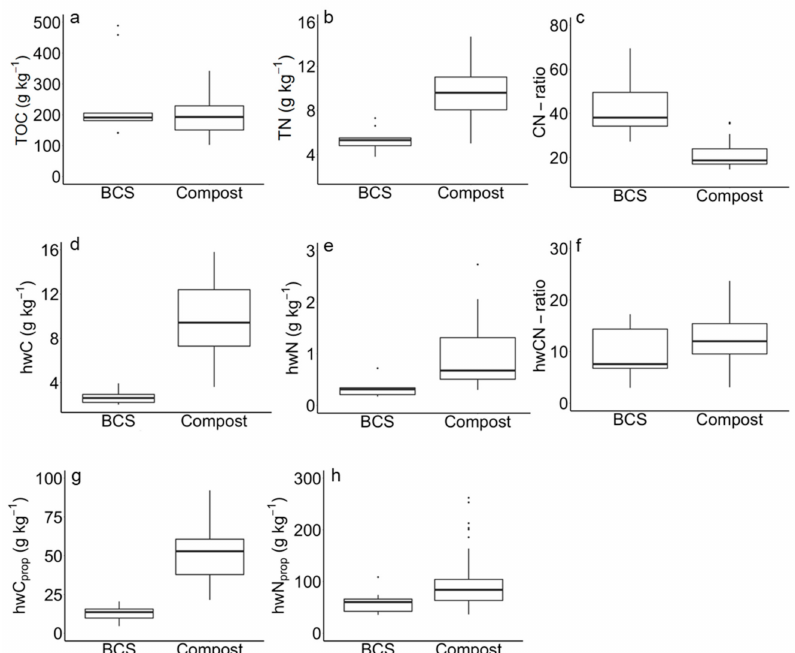
Figure 2. Conventionally analyzed properties of unfractionated compost and BCS samples ( n = 45) of ( a ) total organic carbon (TOC), ( b ) total nitrogen (TN), ( c ) ratio of TOC to TN (CN-ratio), ( d ) hot- water extractable carbon (hwC), ( e ) hot-water extractable nitrogen (hwN), ( f ) ratio of hwC to hwN (hwCN-ratio), ( g ) proportion of hwC to TOC (hwC prop ), ( h ) proportion of hwN to TN (hwN prop